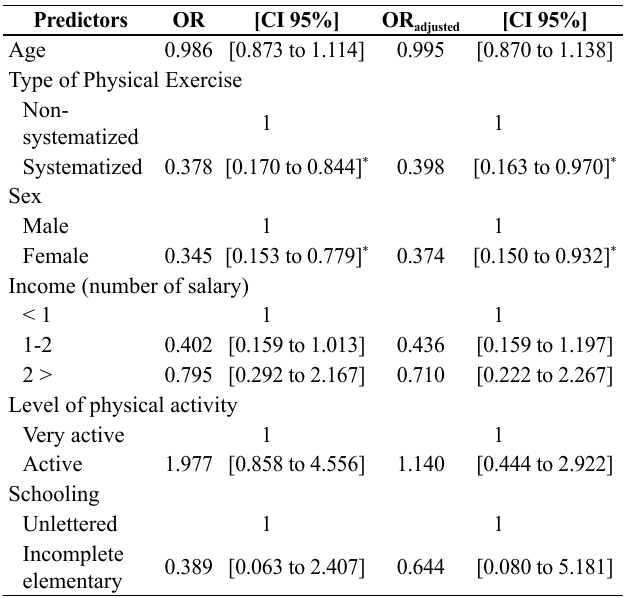
Table 4. Factors associated with the memory lower than expected for age in the elderly.